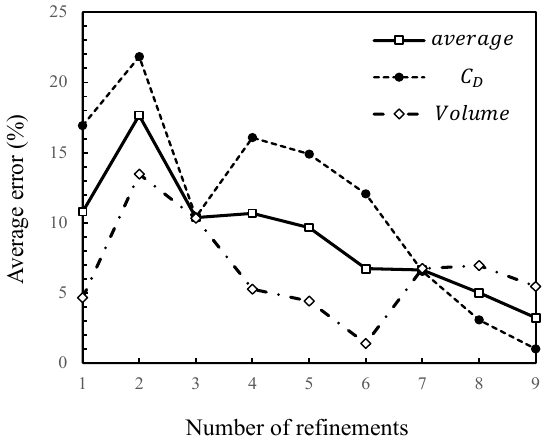
Figure 8. Model error with the refinement process.